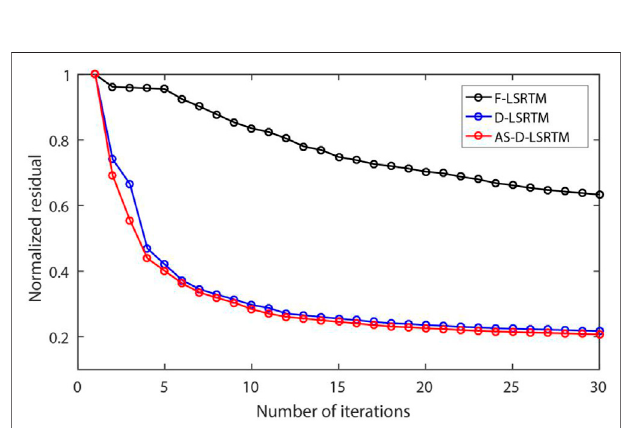
FIGURE 9 | Normalized residual convergence curves of the three methods.